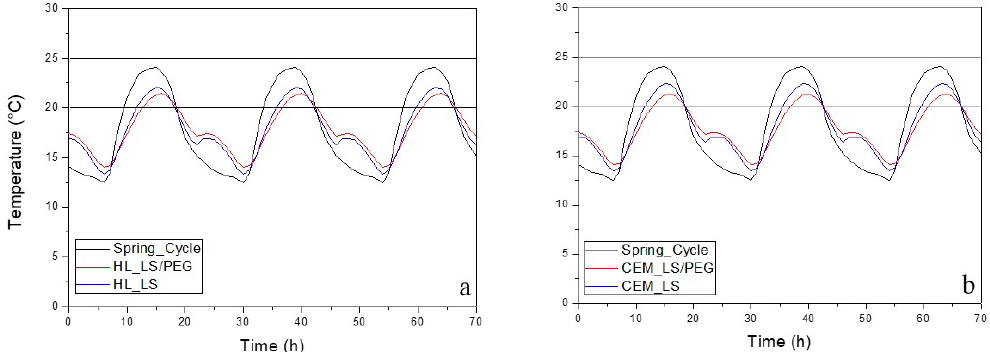
Figure 6. Thermal behavior in spring of developed mortars: ( a ) hydraulic lime-based mortar and ( b ) cement-based mortar. The thermal comfort zone is between 20–25 °C.